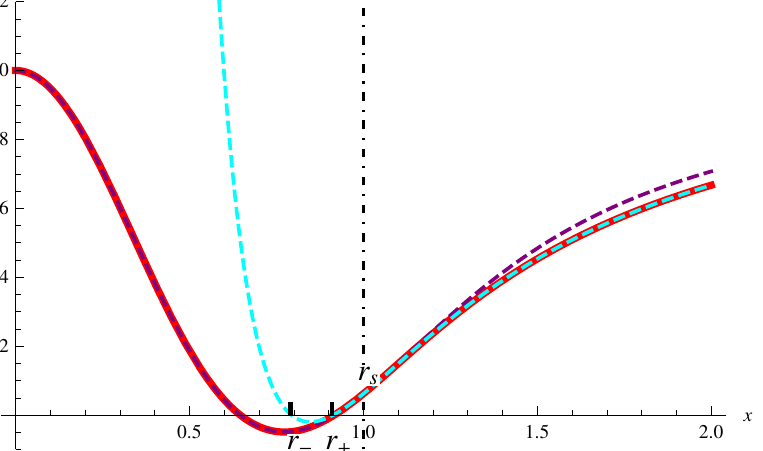
Figure 4. An example of β ≤ β 1 , β > β 2 and β > β 3 : n = 5, β = 0.052. This case is characterized by r s > r +